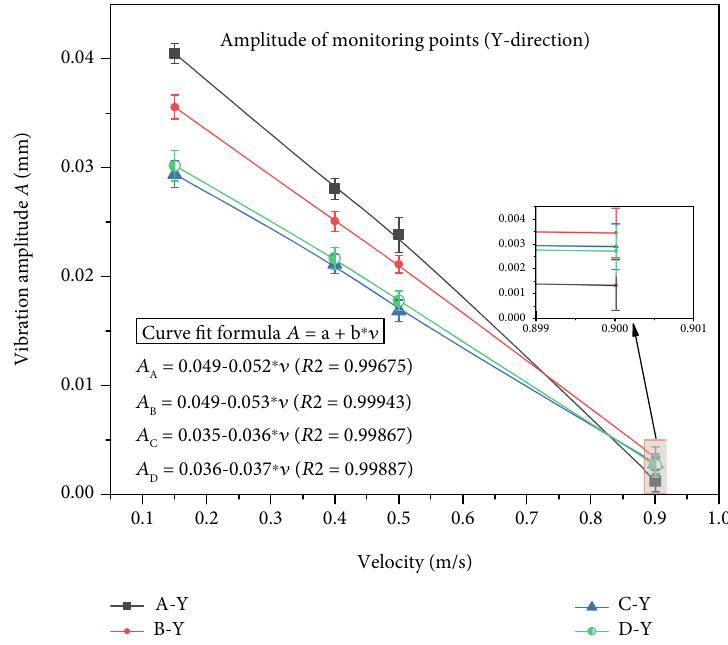
Figure 9: The vibration amplitude in Y -direction under di ff erent water inlet